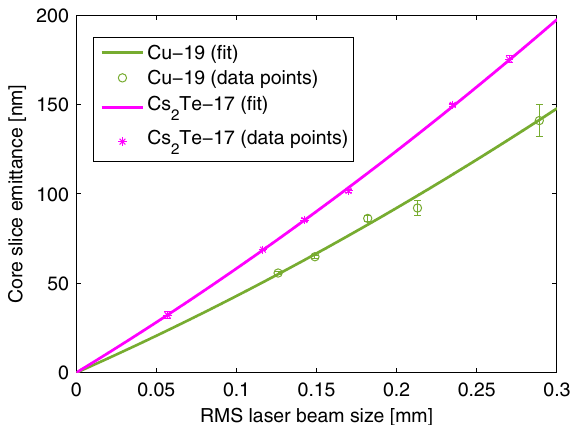
FIG. 3. Measured emittance along the bunch length (slice index) for different bunch charges Q (upper plot). Core slice emittance as a function of the bunch charge (lower plot). For charges equal or below 1.5 pC the slice emittance is not affected by space charge.